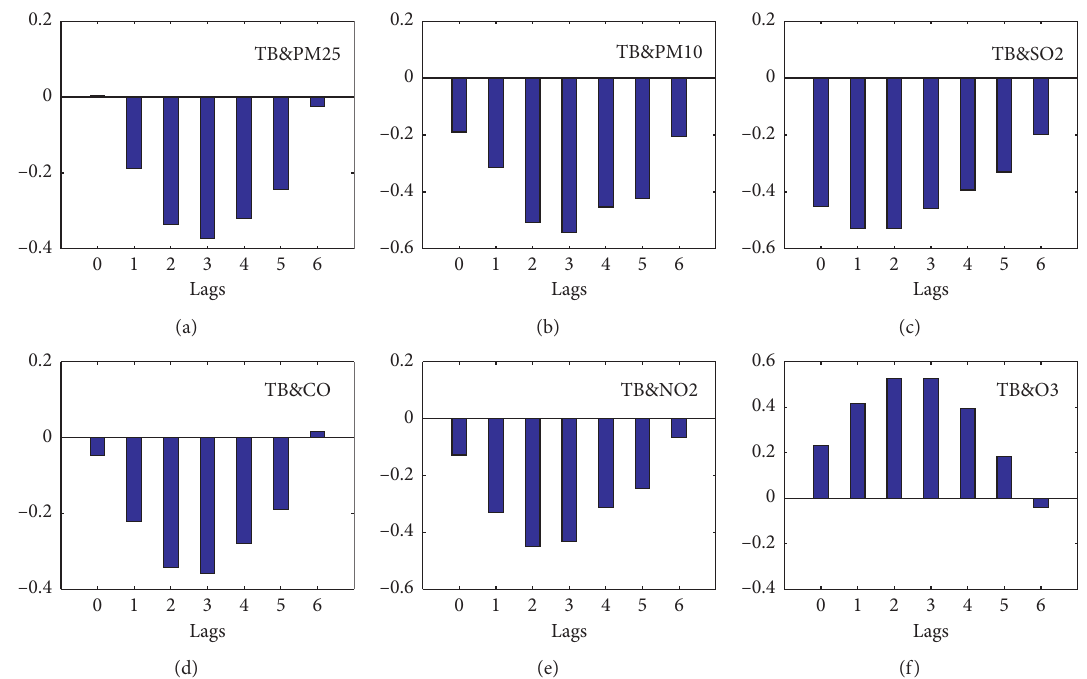
Figure 6: Cross-correlation analysis of TB incidence to air pollution variables.